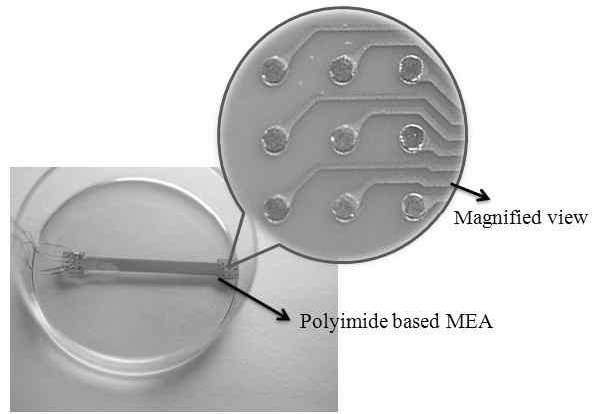
Figure 4. The implemented micro-electrode array.